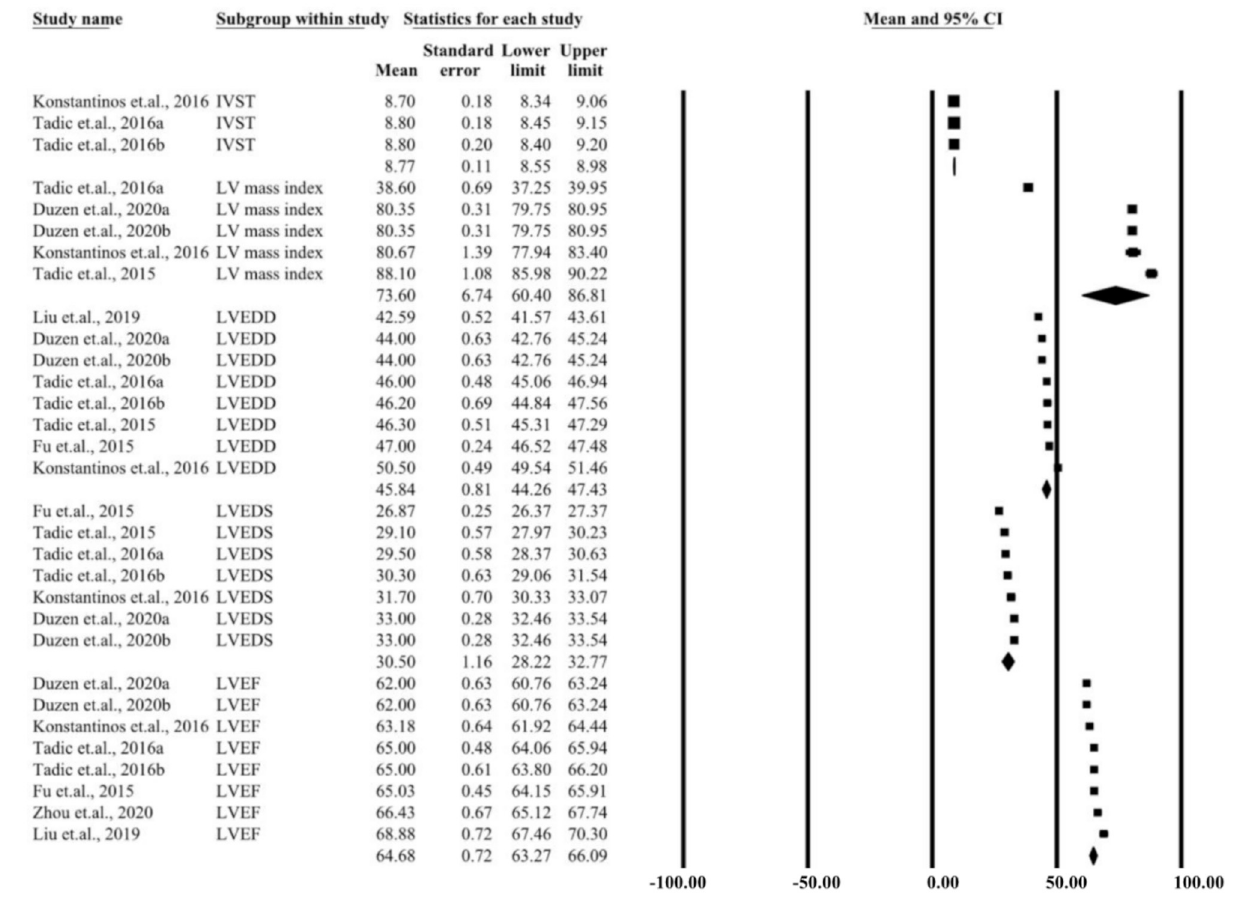
Frontiers in Cardiovascular Medicine |